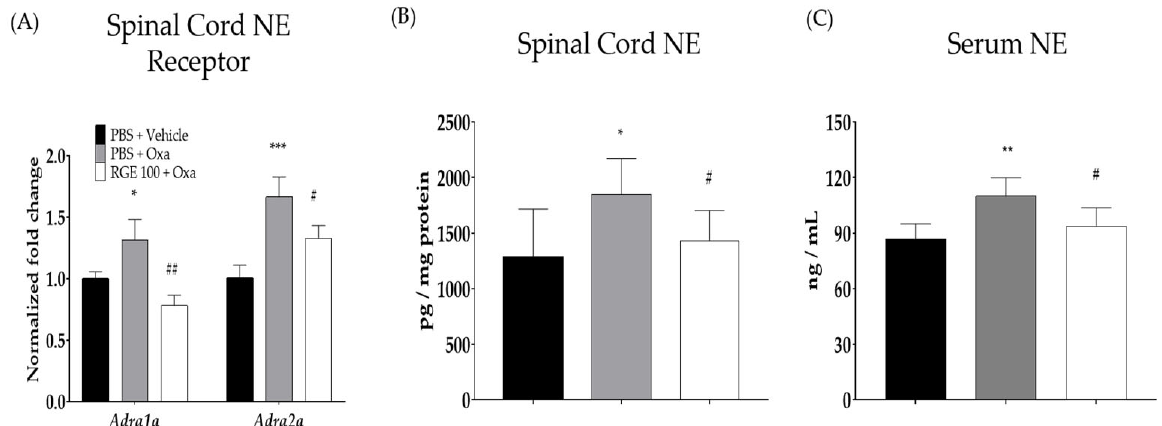
Figure 3. Quantitative RT-PCR testing of adrenergic receptors in the spinal cord and noradrenaline levels in the serum and spinal cord. The effects of oxaliplatin on spinal α 1- and α 2-adrenergic receptors ( A ) and noradrenaline levels in the serum ( B ) and spinal cord ( C ). Note: α 1-ADR: α 1-adrenergic receptor; α 2-ADR: α 2-adrenergic receptor; NE: noradrenaline. N = 6 for each group. Data were experiments and expressed as mean value ± SD. Note: *** p < 0.001, ** p , ## p < 0.01, * p , # p < 0.05 vs. control with Student’s t ‐ test.